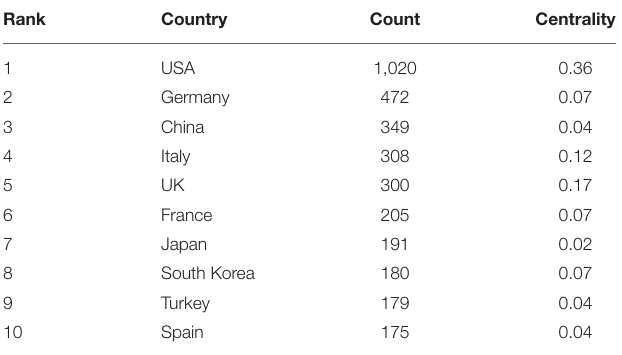
TABLE 1 | Top 10 most published countries in the field of olfactory dysfunction from 2002 to 2021. Rank